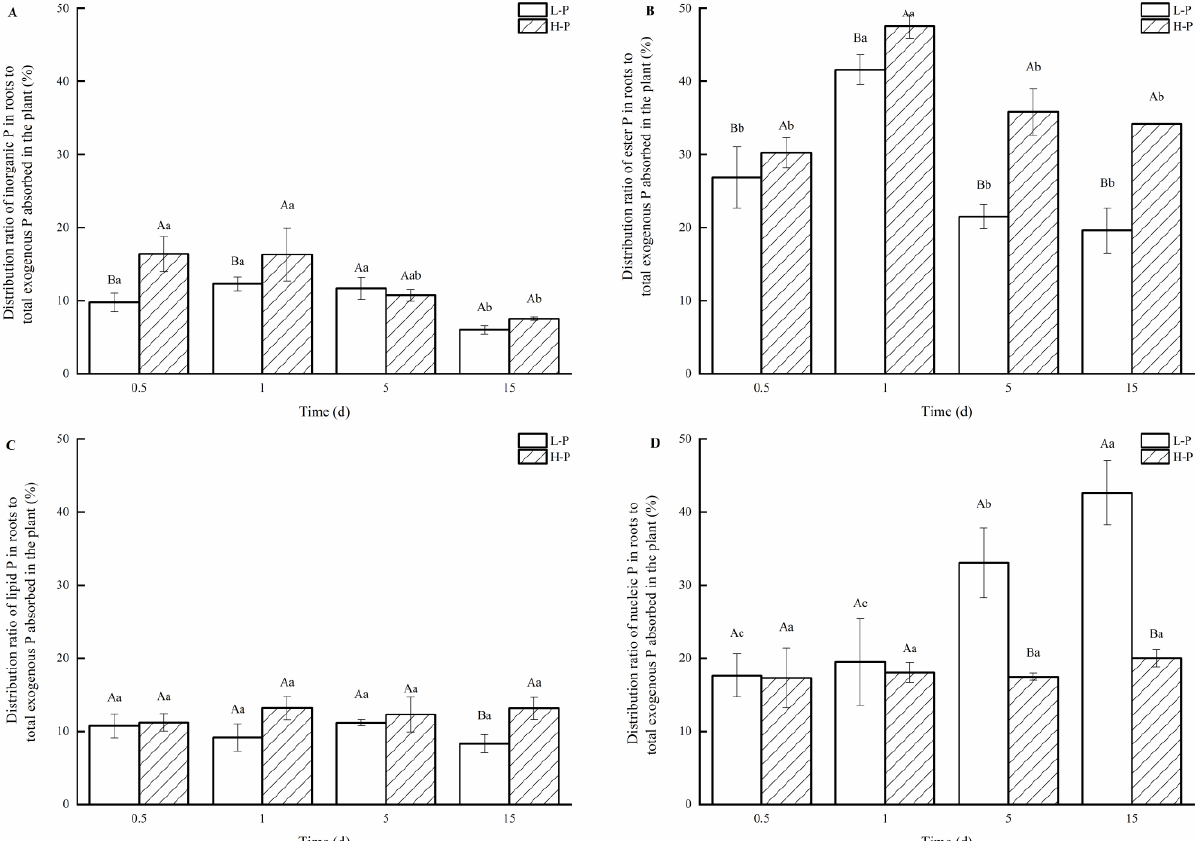
Figure 6. Percentage of different P fractions in roots to total exogenous P absorbed in the plant under high- and low-P treatments: ( A ) inorganic P, ( B ) ester P, ( C ) lipid P, and ( D ) nucleic P. “L-P” and “H-P” represent the low-P and high-P treatments, respectively. Error bars represent standard error, and each point in the figures represents the mean of the five replicates ( n = 5). Lowercase letters indicate significant differences ( p < 0.05) at different treatment times under the same P treatment. Uppercase letters indicate significant differences ( p < 0.05) between different treatments at each time